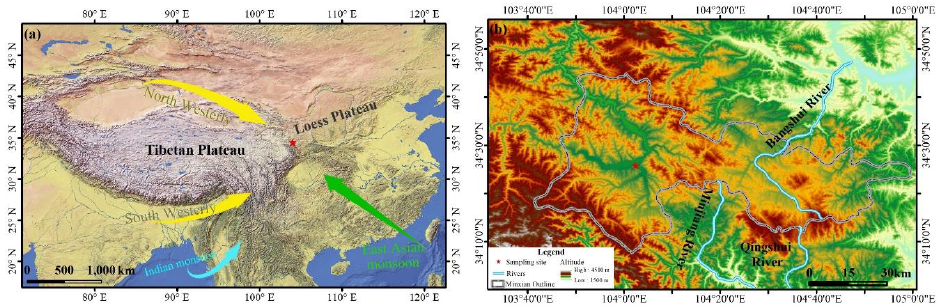
Figure 1. Map showing the location of Minxian ( a ) in the Loess Plateau ( b ).